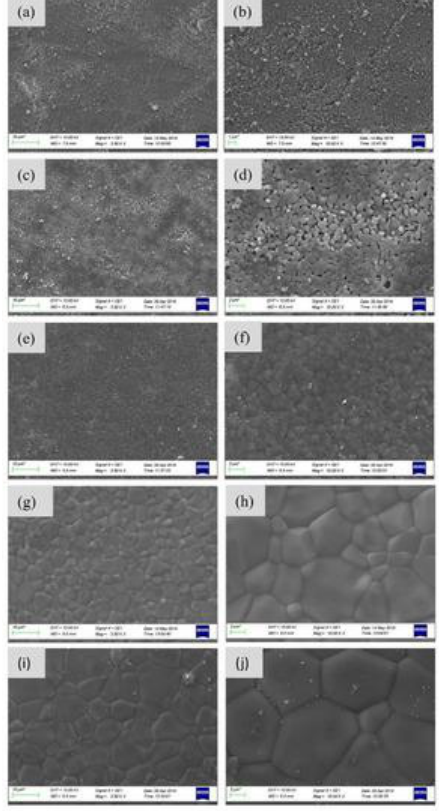
Figure 5. SEM images of porous structures in case of BCP powder derived from salmon fish bones at different sintering temperatures: ( a , b ) 800 °C, ( c , d ) 1000 °C, ( e , f ) 1100 °C, ( g , h ) 1200 °C, and ( i , j ) 1300 °C. (Magnification bars: 10 µm (left column), 2 µm (right column). Reproduced with permission from [98]. Copyright MDPI, 2020.